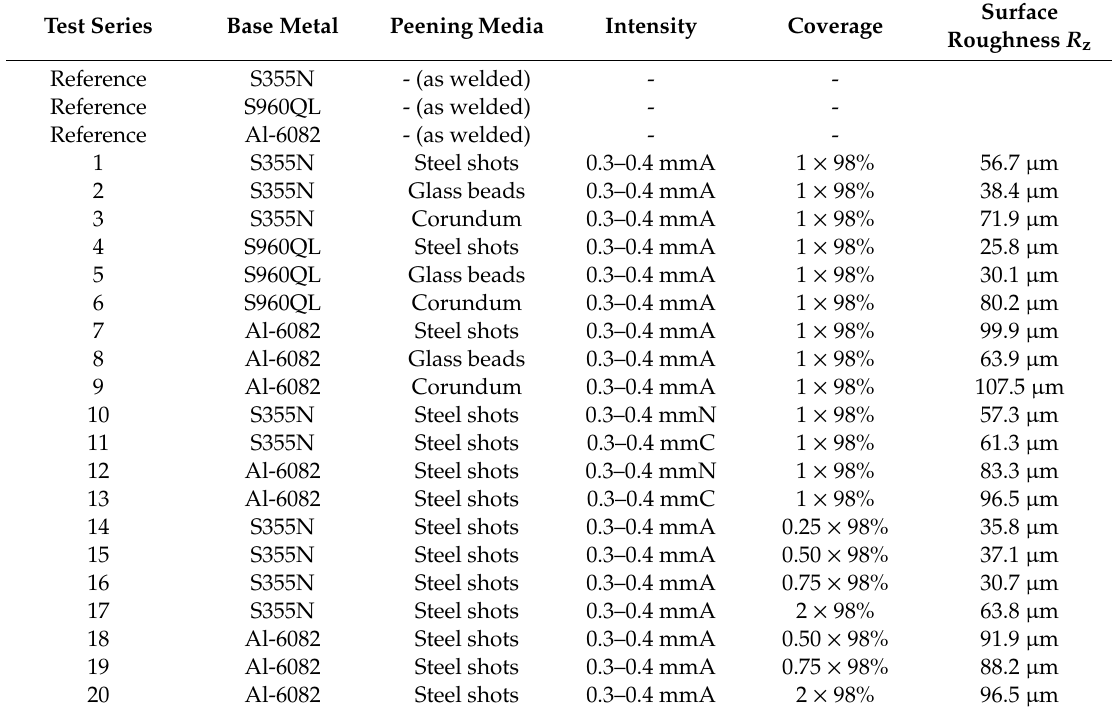
Table 4. Overview about fatigue test series of peened DV-butt welds.